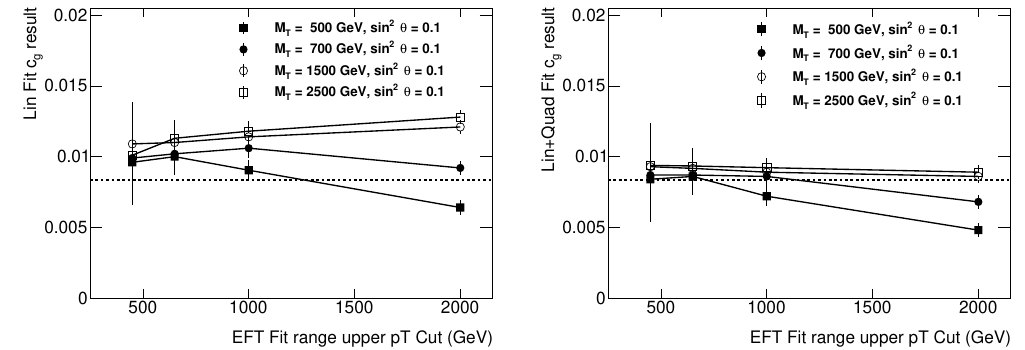
Figure 4. Wilson coefficient c g values obtained in the SMEFT fit with only linear (left) and with linear plus quadratic terms (right) to p H spectra produced from heavy top partner models with T different M T values and sin 2 θ =0.1 as a function of the upper end of the p H fit range. The dashed T lines show the c g values of the SMEFT matching to the